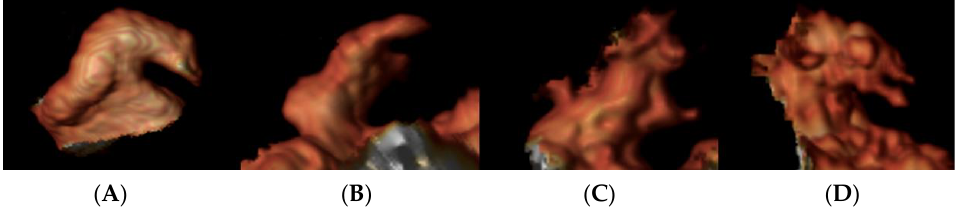
Figure 2. Left atrial appendage morphology on CMR images: Panel ( A ): chicken wing; panel ( B ): wind sock; panel ( C ): cactus; and panel ( D ): cauliflower. wind sock; panel ( C ): cactus; and panel ( D ):